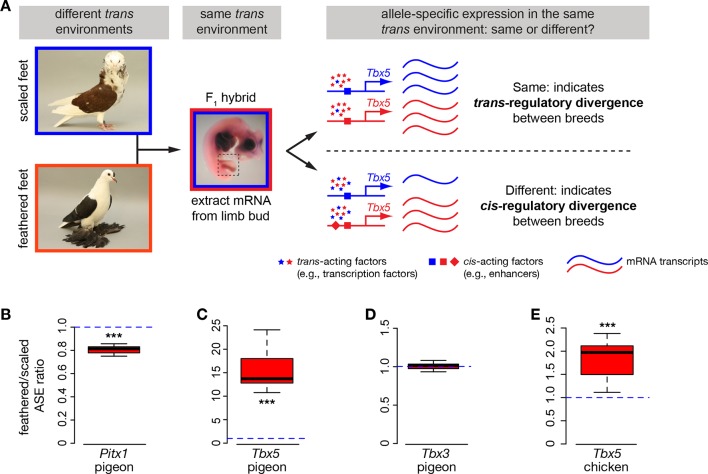
Allele-specific expression (ASE) assays demonstrate cis-regulatory changes in Pitx1 and Tbx5.(A) Schematic of ASE assay using Tbx5 expression as an example. Differences in Tbx5 expression between scale-footed and feather-footed breeds could be due to trans- and/or cis-acting mutations. If expression differences between parental breeds are due to trans changes only (stars), then expression of the two Tbx5 alleles in hybrid embryos will be the same (top right). In contrast, if cis-regulatory changes underlie differences in Tbx5 expression between the parental breeds, then expression of the two Tbx5 alleles in hybrid embryos will be different (bottom right). (B-D) ASE assay in hybrid hindlimb buds indicate cis-regulatory divergence between scale-footed (Old Dutch Capuchine) and muffed (fairy swallow) pigeon breeds in Pitx1 (B) and Tbx5 (C), but not in Tbx3 (D). Dashed blue line indicates null hypothesis of equal expression of alleles. (E) ASE assay in hybrid hindlimb buds indicate cis-regulatory divergence in Tbx5 between feather-footed (silkie) and scale-footed (white leghorn) chicken breeds. Boxes in (B-E) span 1st to 3rd quartiles, bars extend to minimum and maximum observed values if within 1.5 times the interquartile range of the box, circles indicate values outside of this range, black line indicates median. **p≤0.01 ***p≤0.005.DOI:
http://dx.doi.org/10.7554/eLife.12115.01610.7554/eLife.12115.017Figure 4—source data 1.Source data from pyrosequencing ASE experiments.Abbreviations: fl, embryonic forelimb; hl, embryonic hindlimb.